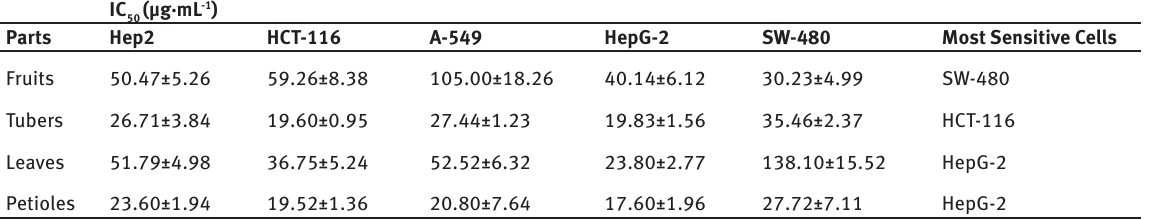
Table 2: The antiproliferative activity of essential